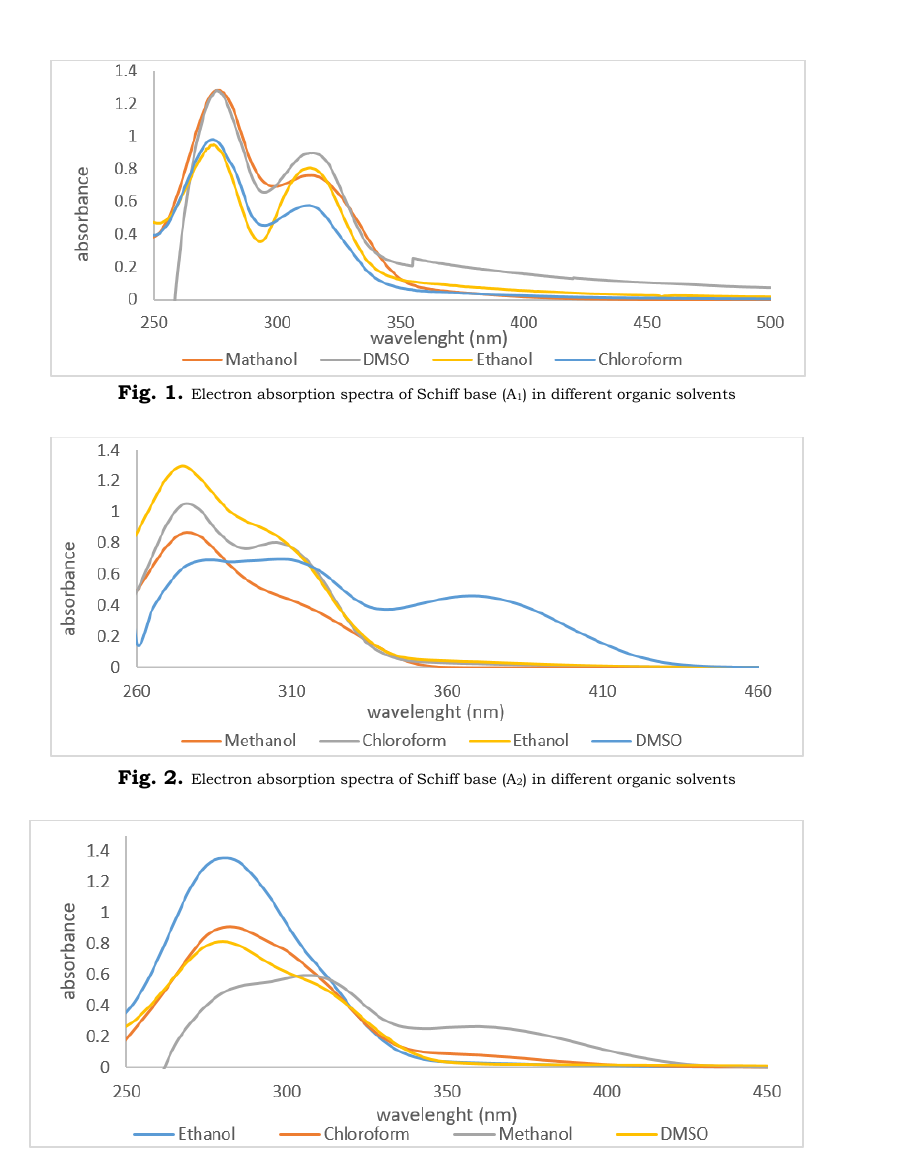
Fig. 3. Electron absorption spectra of Schiff base (A 3 ) in different organic